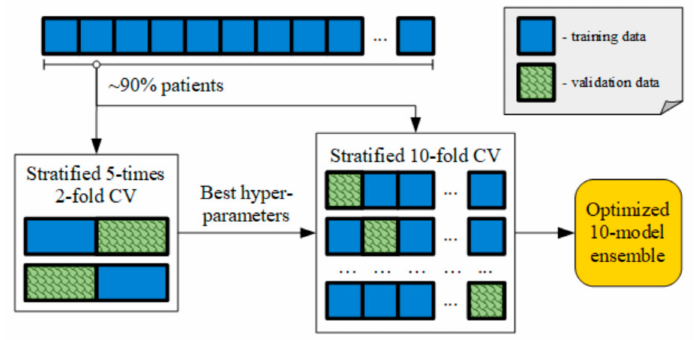
Figure 6. Model selection routine combining 5-times 2-fold cross-validation for hyperparameter selection and 10-fold cross-validation to obtain an optimised 10-model